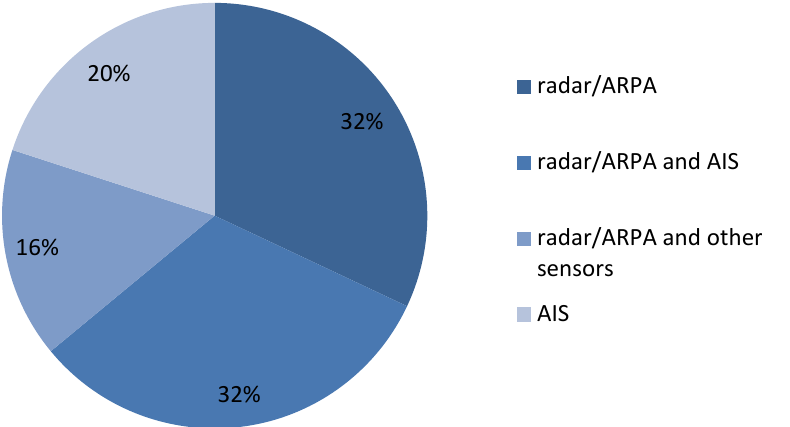
Figure 9. A comparison of analyzed approaches: source of input data.